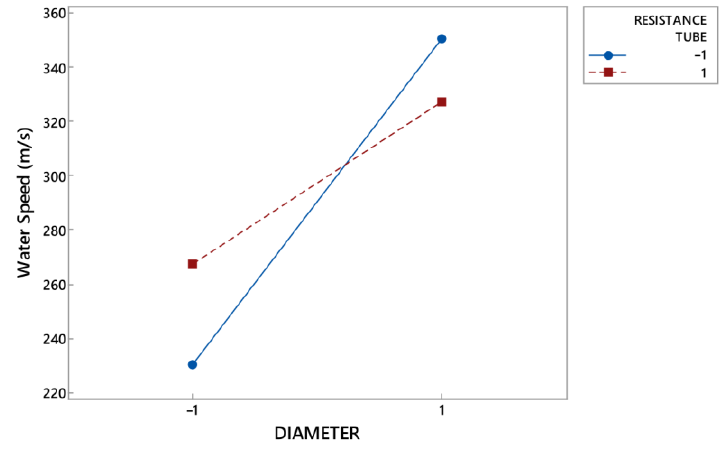
Figure 13. Interaction plot of “Diameter” and “Inner Tube Resistance”. Figure 13. nteraction plot of “Diameter” and “ nner Tube esistance”.